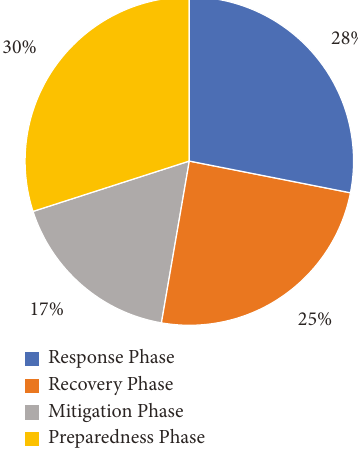
Figure 4: Participation of respondents in the Table 5: Risk ranking in the DMC phases.